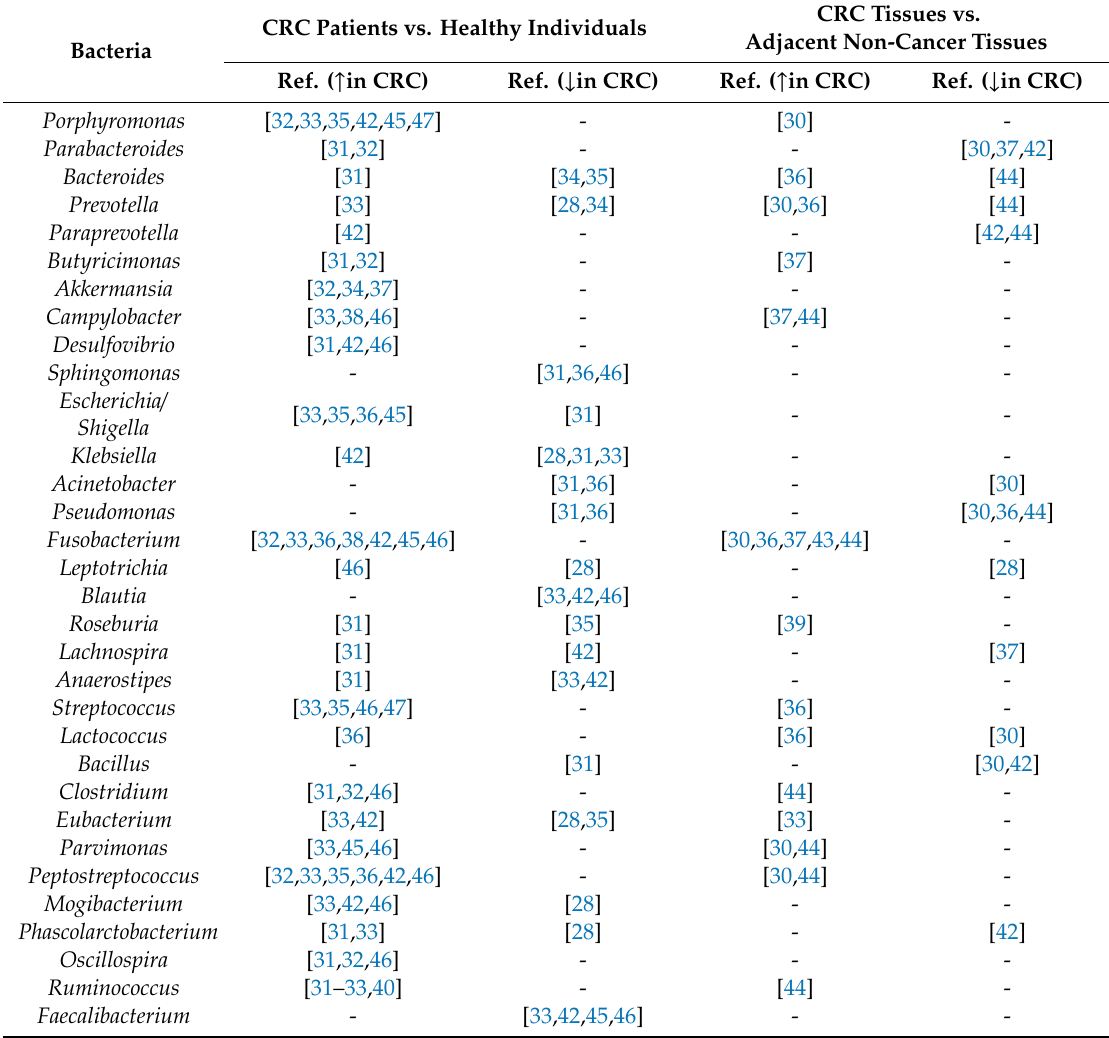
Table 2. Altered bacterial populations in CRC patients compared to healthy individuals, and in CRC tissues compared to adjacent non-cancer